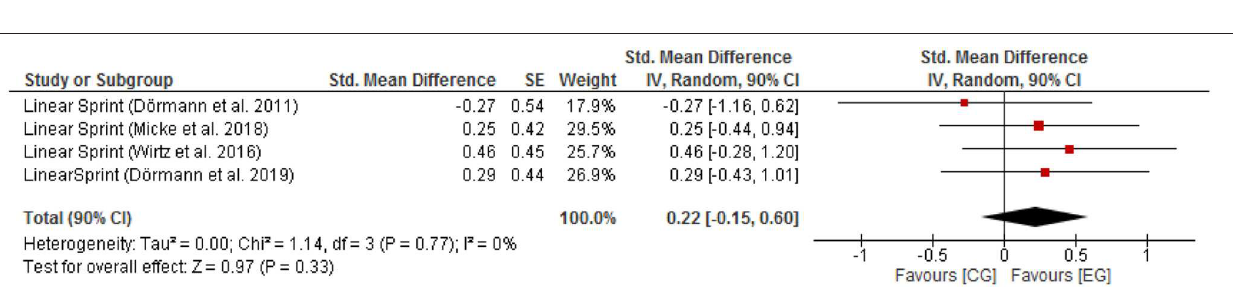
FIGURE 3 | Linear sprint for CG vs. EG. SE, standard error; CI, confidence interval; Std., standardized; IV, independent variable.